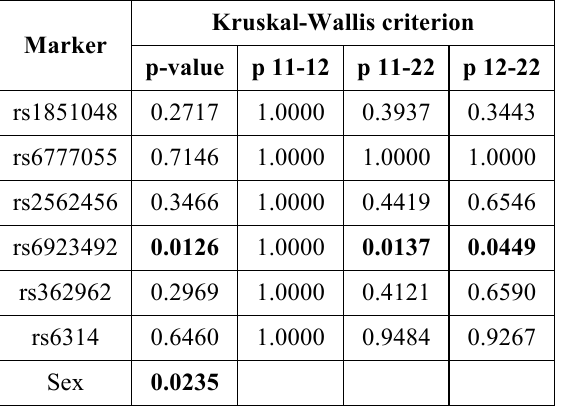
Table 4: Association with genetic markers of pain sensitivity threshold.